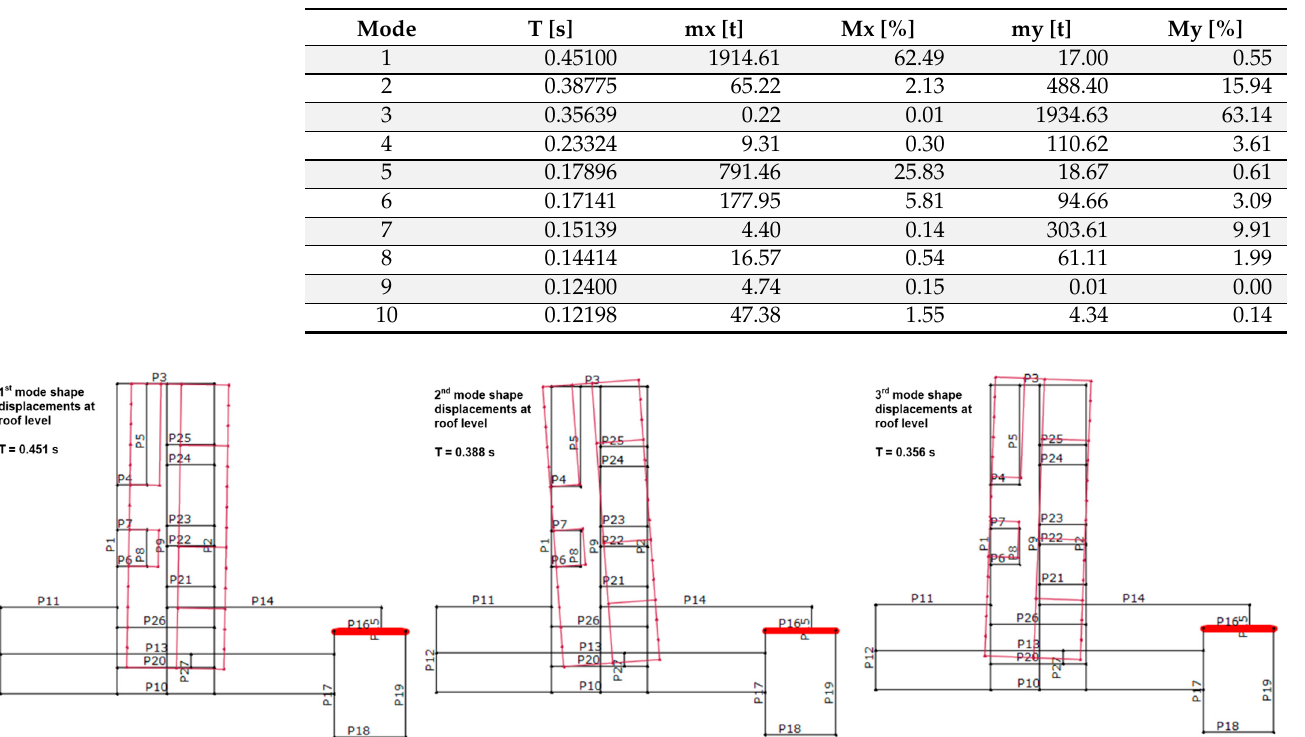
Table 3. Eigenmode periods obtained by EFM.